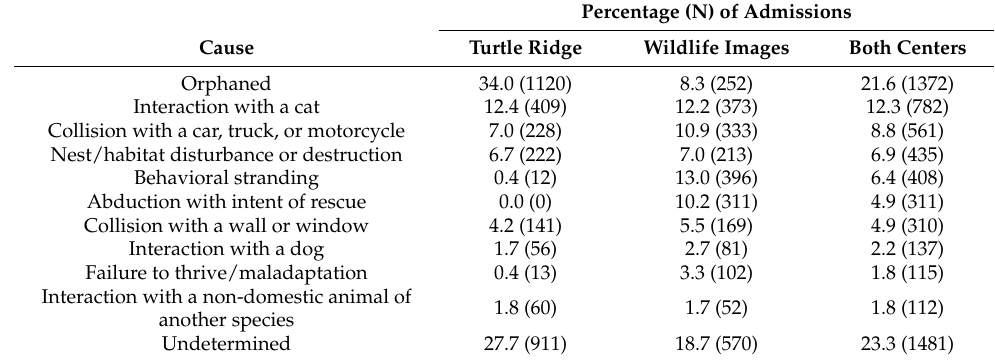
Table 3. Percentages and numbers of total admissions for the ten most frequently reported causes of admission from both wildlife rehabilitation centers, as well as frequency of undetermined cause of